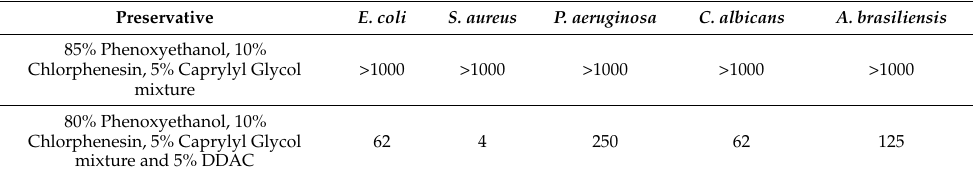
Table 3. MIC values (expressed in ppm) of 85% Phenoxyethanol, 10% Chlorphenesin, 5% Caprylyl Glycol mixture; and 80% Phenoxyethanol, 10% Chlorphenesin, 5% Caprylyl Glycol and 5% DDAC. Preservative E. coli S. aureus